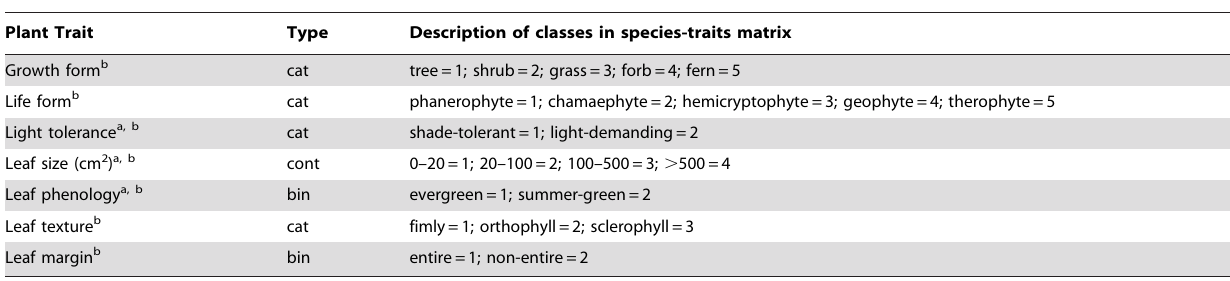
Table 2. Seven plant traits recorded for 160 species in the four study sites.